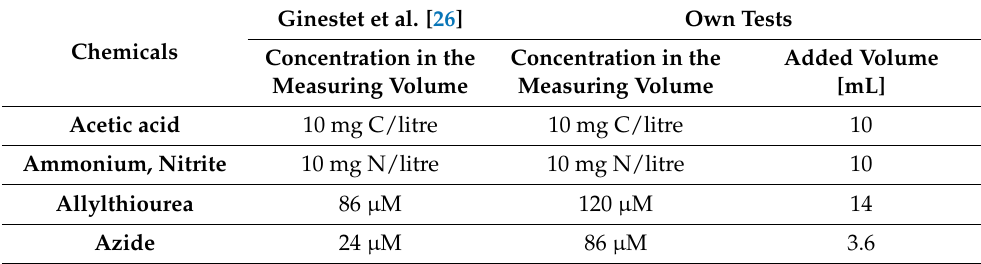
Table 3. Concentration and volumes for selective OUR measurements.